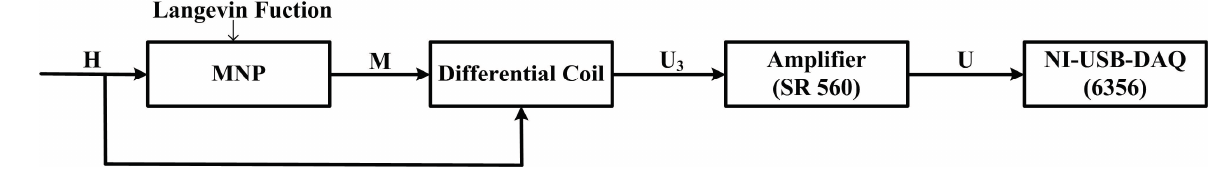
Figure 3. Signal transmission path of the magnetic detection